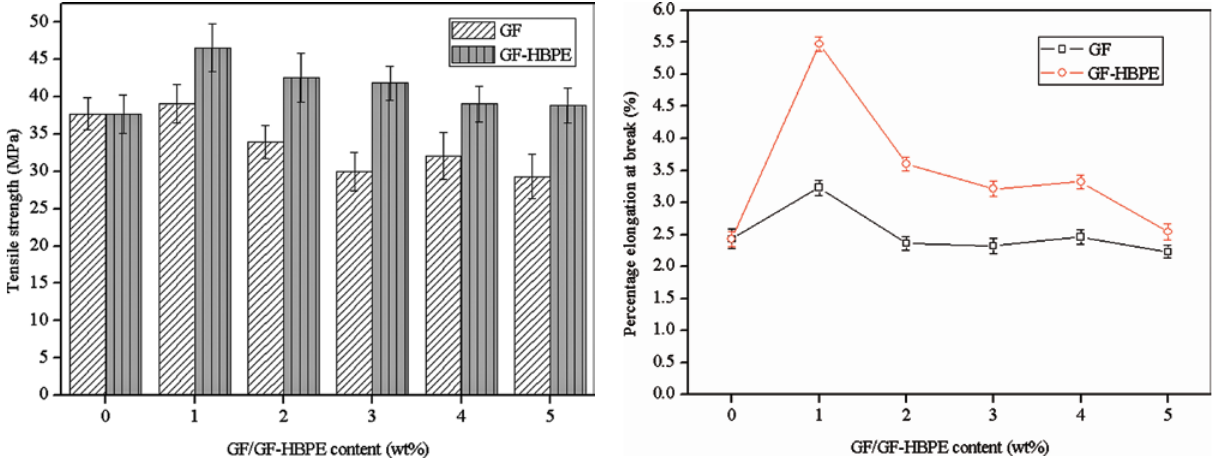
Figure 6: Tensile strength of epoxy composites. Figure 7: Percentage elongations at break of epoxy composites.